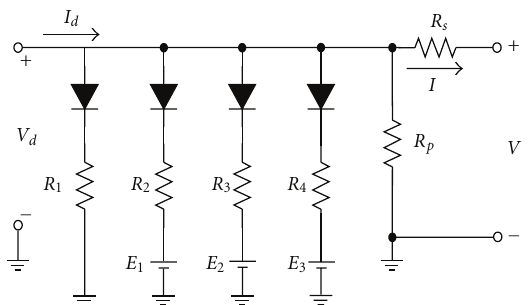
Figure 3: A solar cell model using a piecewise linear approximation.